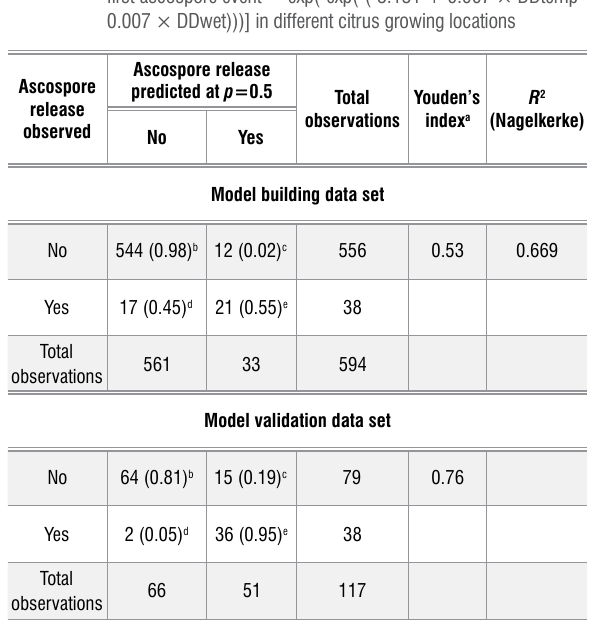
Ascospore release observed